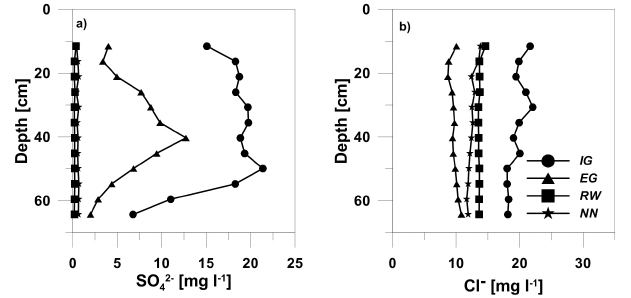
Fig. 4. Vertical profiles of mean (a) sulfate and (b) chloride concen- trations at the study sites.